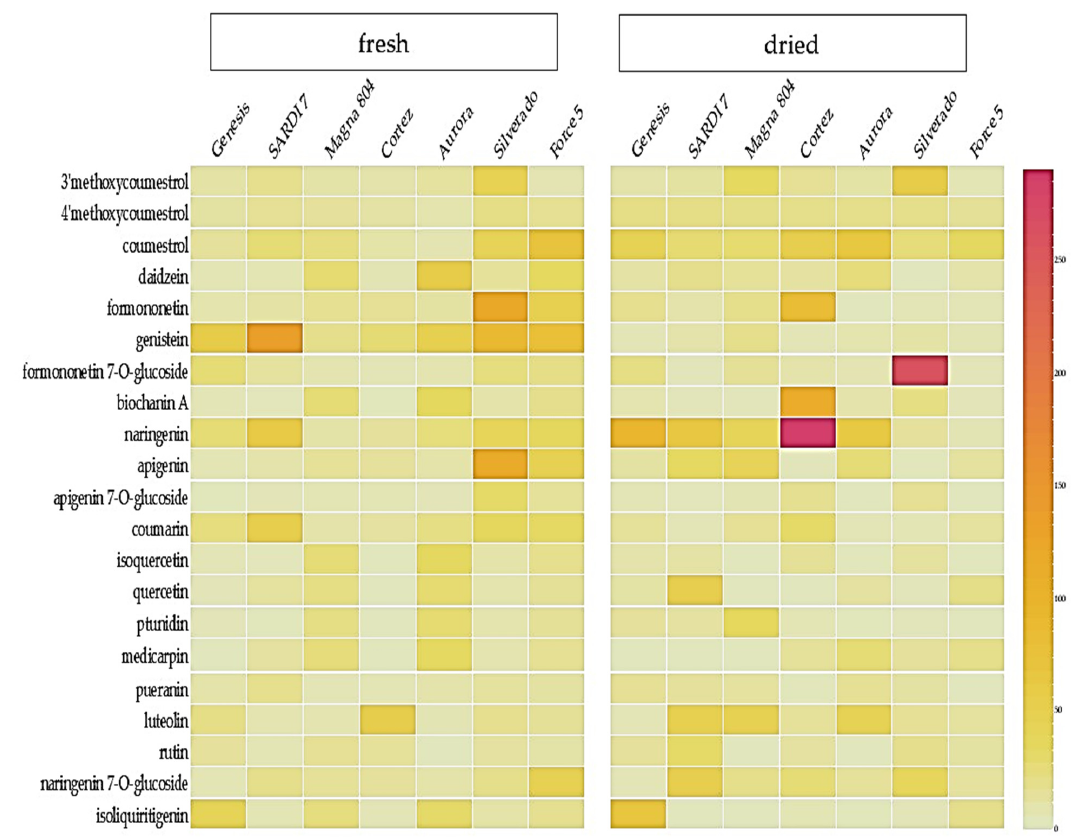
Figure 2. Heat map demonstrating the relative abundance of flavonoids in fresh and dried samples from seven lucerne cultivars produced under glasshouse conditions.